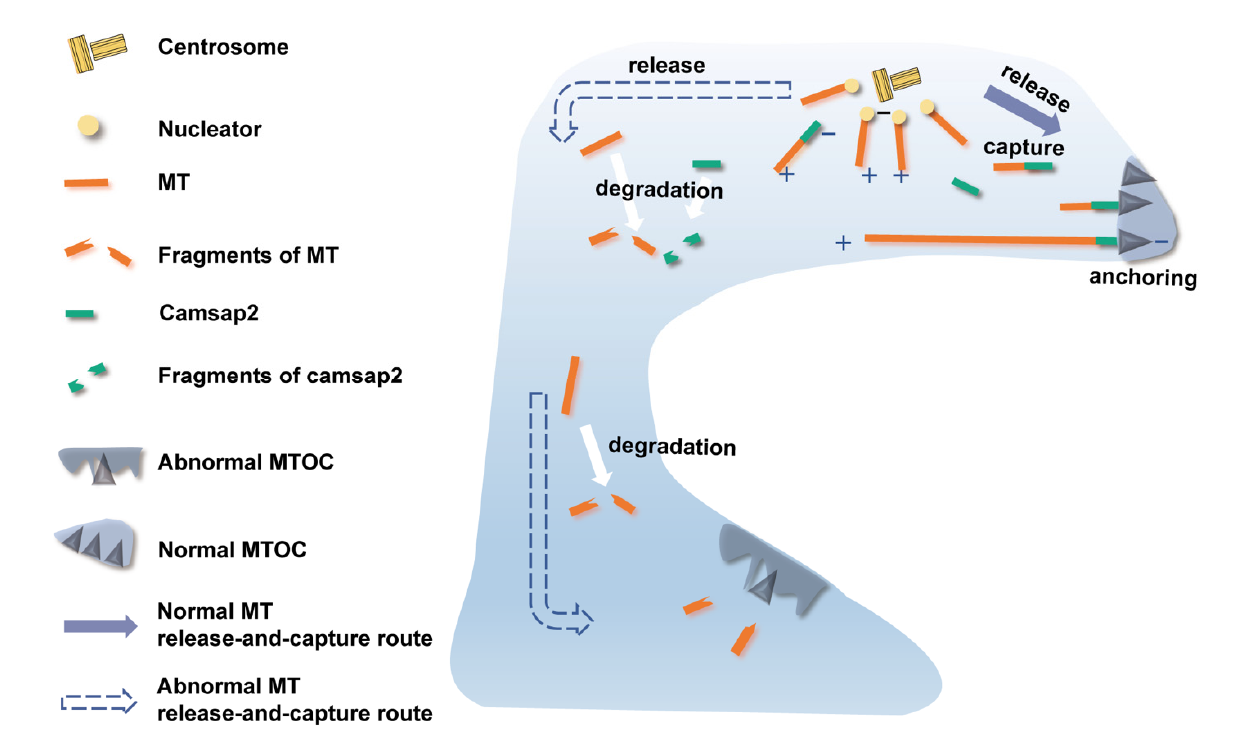
Figure 8. Schematic diagram showing the normal and abnormal MT release-and-capture routes in PCs (taking IPC as an example). MT nucleation occurs at centrosome. Minus ends of MTs are released, successfully captured, and anchored at the non-centrosomal MTOC near the centrosome but fail to be captured and anchored at the non-centrosomal MTOC far from the centrosome. MTOC: